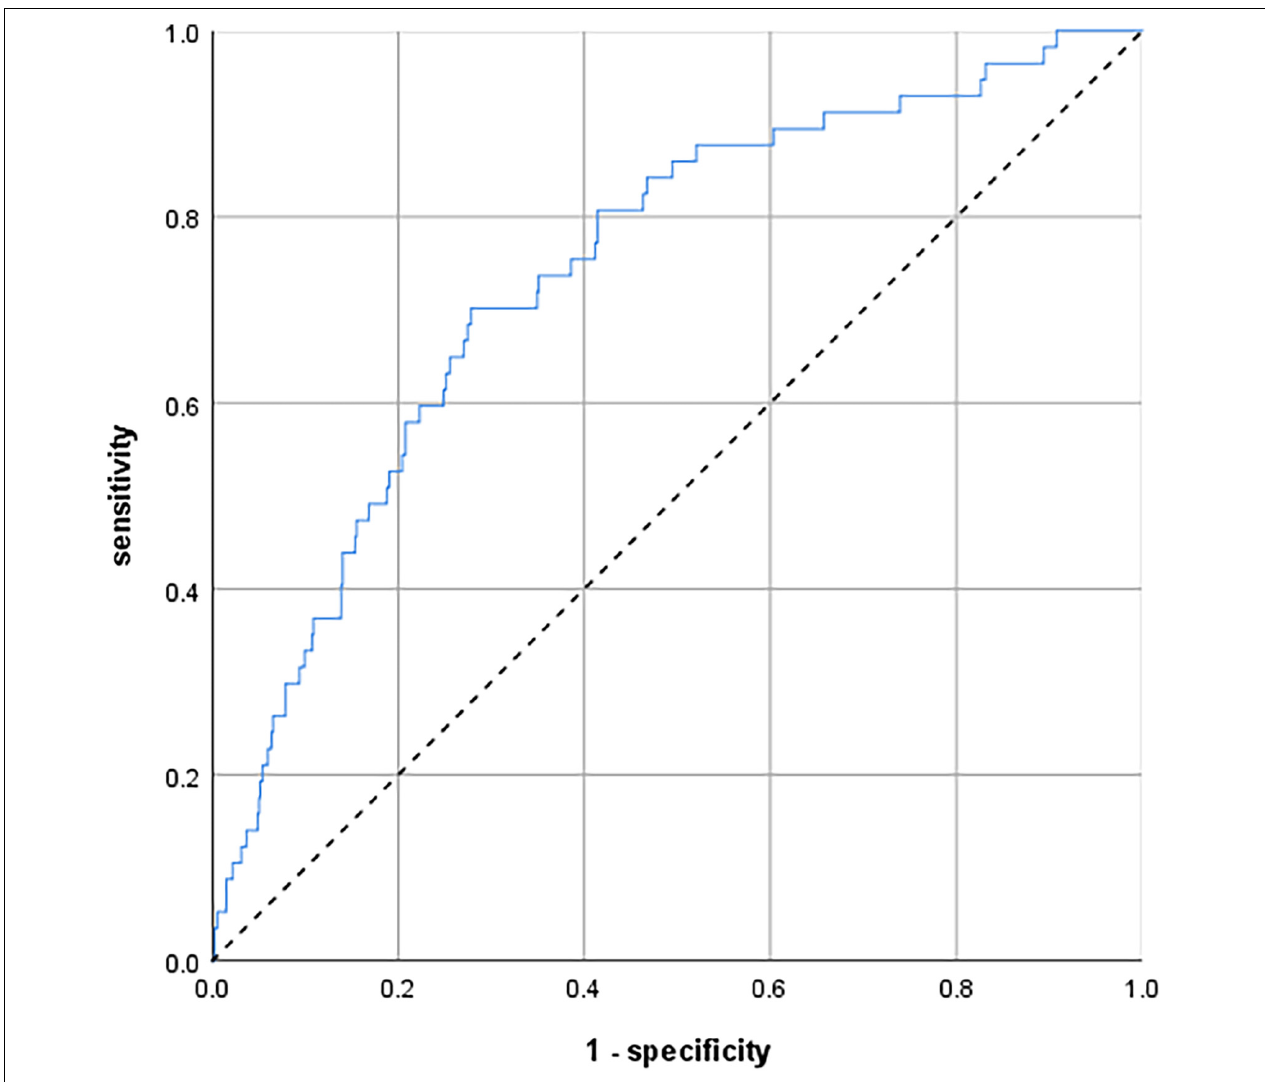
FIGURE 2 | Receiver operating characteristic (ROC) curves illustrating a predicting model to calculate the individual risk of delirium symptoms over 8 years. The model comprises age, comorbidities, depression, and executive function. N = 793. Area under the curve (AUC) = 0.743 (95% confidence interval 0.678–0.808).